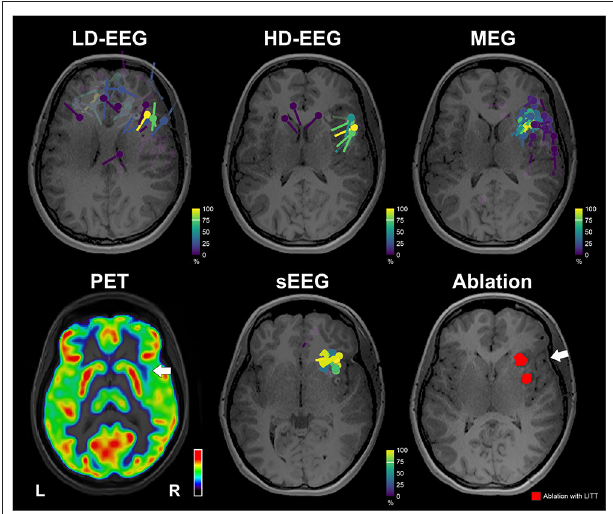
FIGURE 4 | Neuroimaging findings with respect to ablation. Upper: Dipoles clustering overlaid on patient’s MRI for the conv-EEG, HD-EEG, and MEG. Dipoles are color-coded based on clusterness [dipoles with high clusterness (have several other dipoles in its vicinity) are depicted with yellow; dipoles with low clusterness (few or no other dipoles in its vicinity) are depicted with magenta]. Lower: FDG-PET image shows a small region of hypometabolism at the anterior right superior temporal gyrus, indicated by white arrow. Dipoles after clustering for iEEG. Ablation volume (red) overlaid on patient’s MRI. White arrow indicates the location of a possible focus of gliosis identified on patient’s MRI. MRI and PET are displayed on neurological orientation (left to